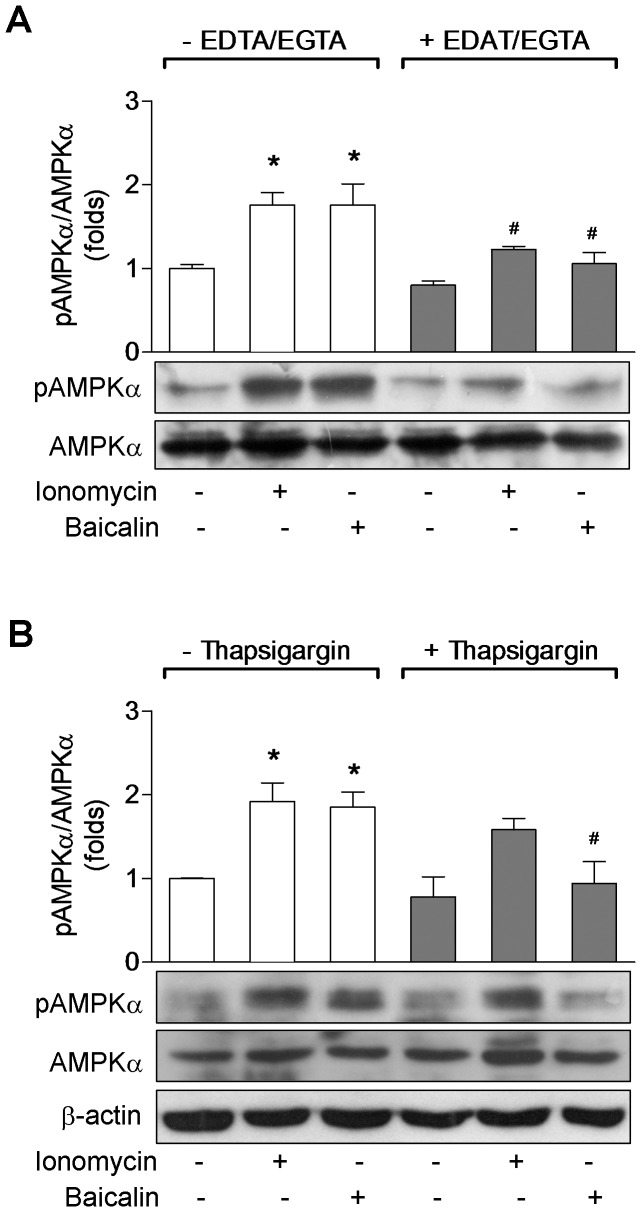
Role of intracellular Ca2+ in baicalin-induced AMPKα phosphorylation.HeLa cells were treated with 5 µM baicalin for 1 hr or 1 µM ionomycin for 5 min in control medium (open bars), Ca2+-free medium containing Ca2+ chelators EDTA and EGTA (solid bars, A), or medium containing 2 µM thapsigarging to deplete intracellular Ca2+ stores (solid bars, B). Phosphorylation of AMPKα at Thr-172 (pAMPKα), total AMPKα and β-actin expression were measured by Western blotting. Histograms represent the fold change in the pAMPKα/AMPKα ratio at least three independent experiments. * p<0.05 compared to control; #
p<0.05 compared to respective treatment group in control medium. Representative Western blots are shown.